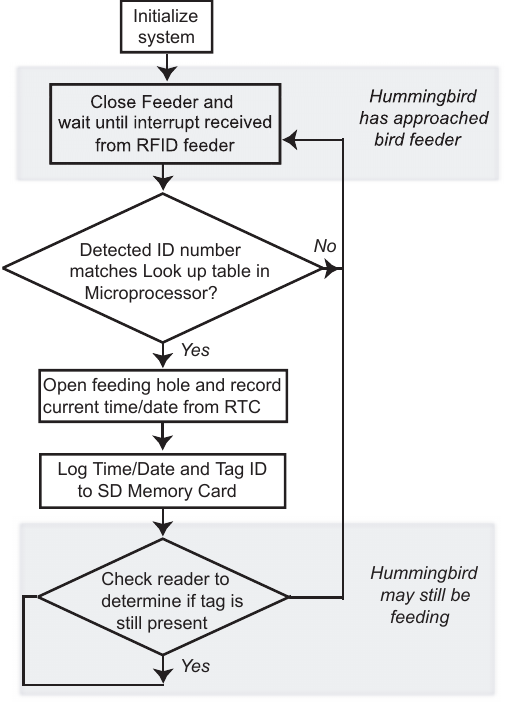
Figure 4. Microcontroller software flow chart.